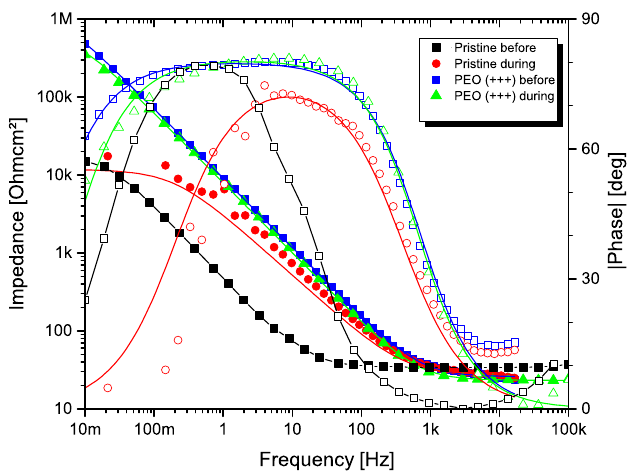
Figure 9. EIS spectra in Bode plot of the pristine titanium material and a PEO treated sample before and during a tribocorrosion test in Hank’s